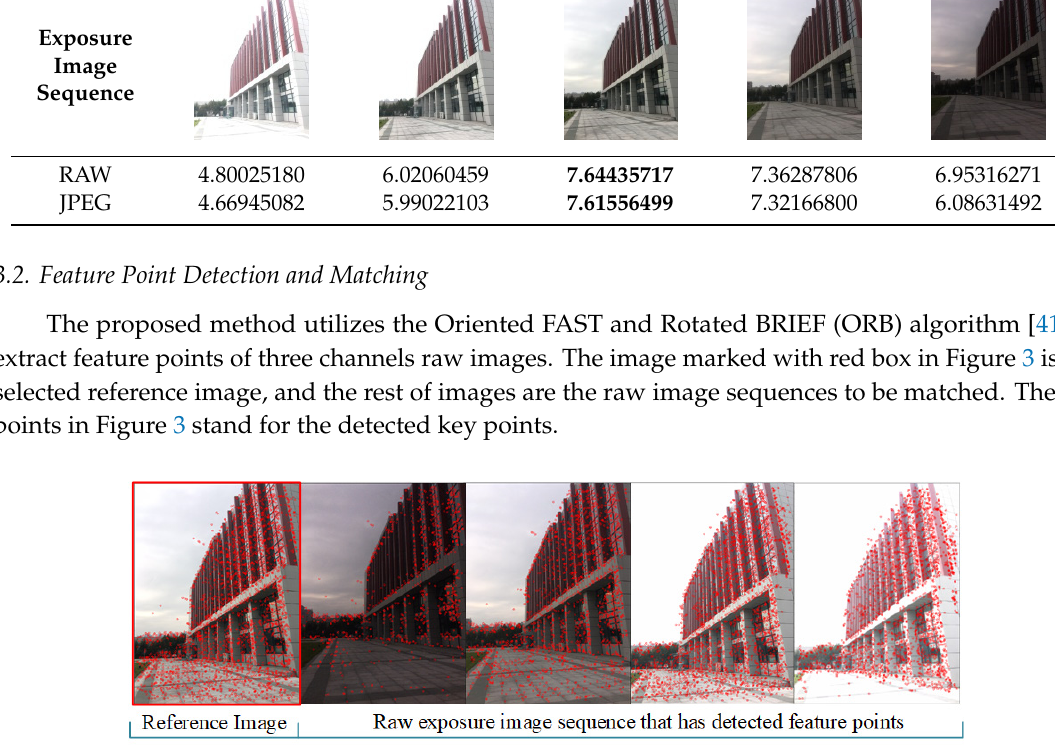
Figure 3. Oriented FAST and Rotated BRIEF (ORB) detection results of the raw image with different levels of exposure.